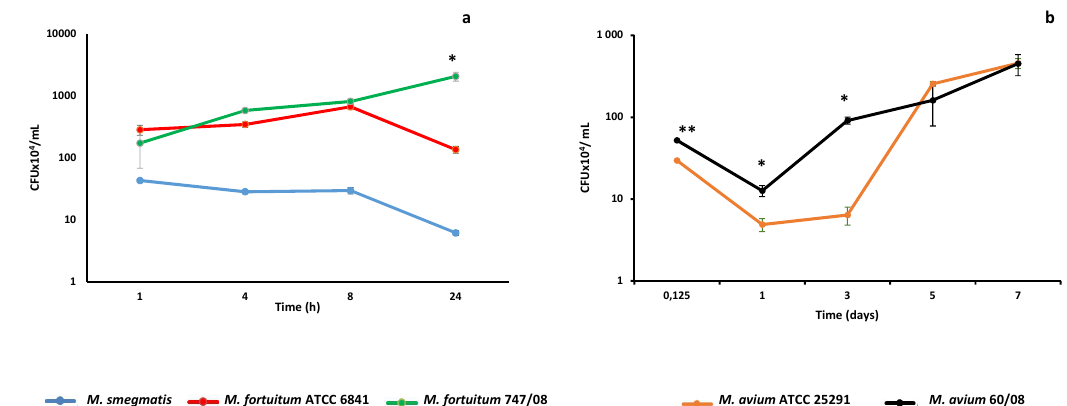
Figure 1. Nontuberculous mycobacteria (NTM) persistence within macrophages. Intracellular persistence of rapidly growing mycobacteria ( a ) and slowly growing mycobacteria ( b ) was followed over 1- and 7-day periods, respectively. (* p < 0.05; ** p < 0.01).